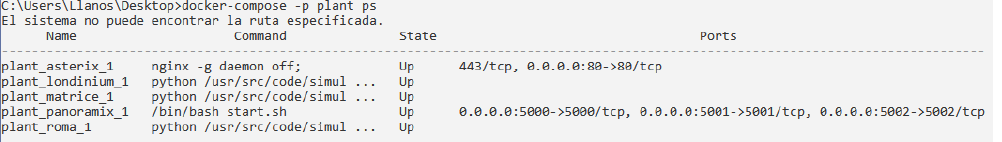
Figure 4. Network Containers Deployed with Docker (corresponding to the Network Structure Represented in Figure